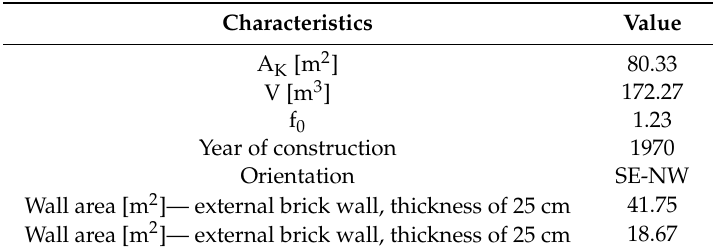
Table 3. Major construction characteristics of the case-study building.